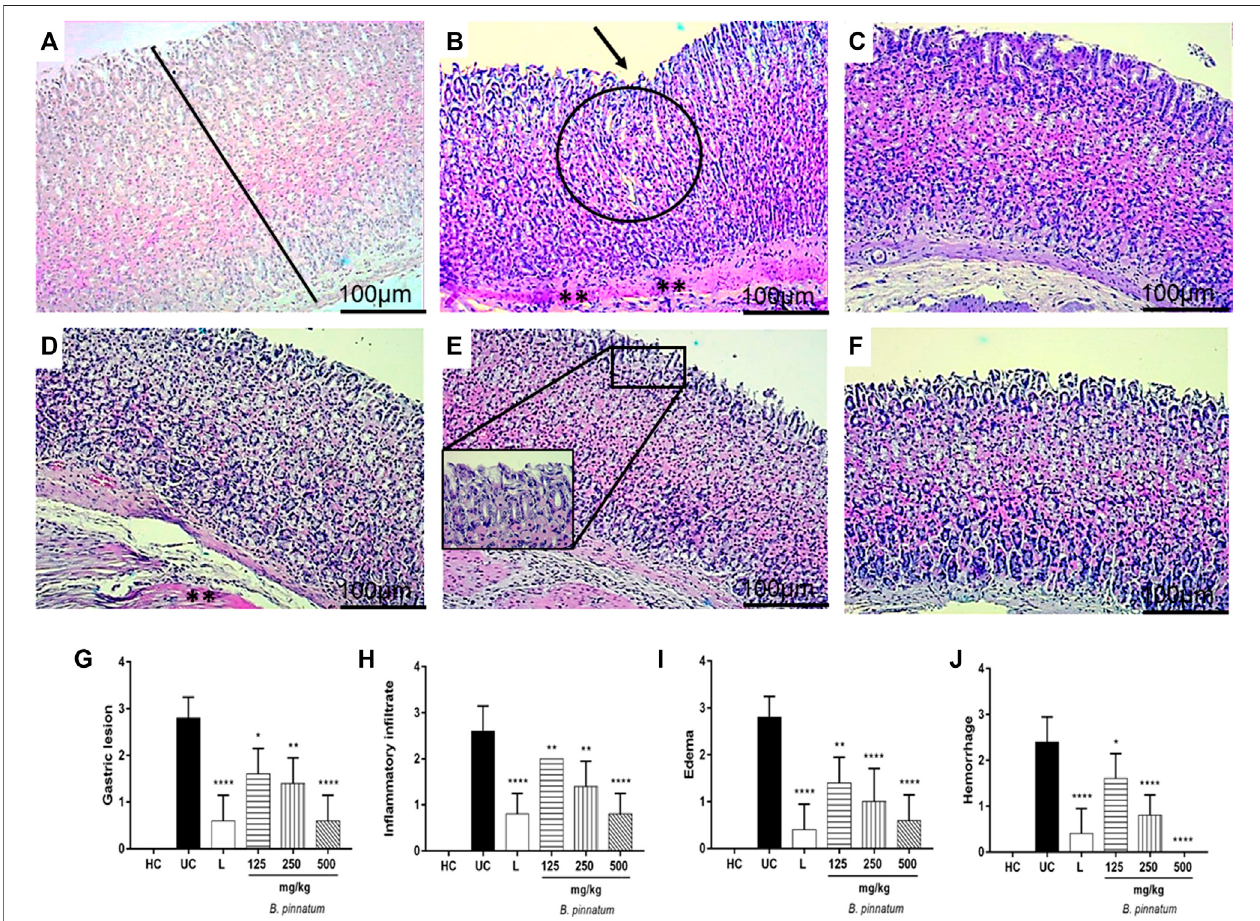
FIGURE 8 | Effect of treatment with B. pinnatum leaf extract (125, 250, and 500 mg/kg) in the histology of acetic acid – induced chronic gastric ulcer model in rats. Histopathological characteristics of the gastric tissue of rats, showing the cut of the stomach in the transverse direction. The H&E stained slides were visualized under a bright fi eld microscope with × 10 magni fi cation. (A) Healthy control; (B) ulcerated control; (C) lansoprazole; (D) B. pinnatum 125 mg/kg; (E) B. pinnatum 250 mg/kg; (F) B. pinnatum 500 mg/kg. The bar indicates gastric mucosa without changes; circle: necrotic lesions; one white arrow: hemorrhage points; one black arrow: distraction of the surface epithelium; two asterisks: intense in fl ammatory in fi ltrate; (G) gastric lesion; (H) in fl ammatory in fi ltrate; (I) edema; (J) hemorrhage. Data expressed as mean ± standard mean error ( n (cid:2) 5). Mann – Whitney used to calculate statistical signi fi cance, * p < 0.05, ** p < 0.01, **** p < 0.0001 vs. ulcerated control. Healthy control, HC; ulcerated control, UC; lansoprazole,